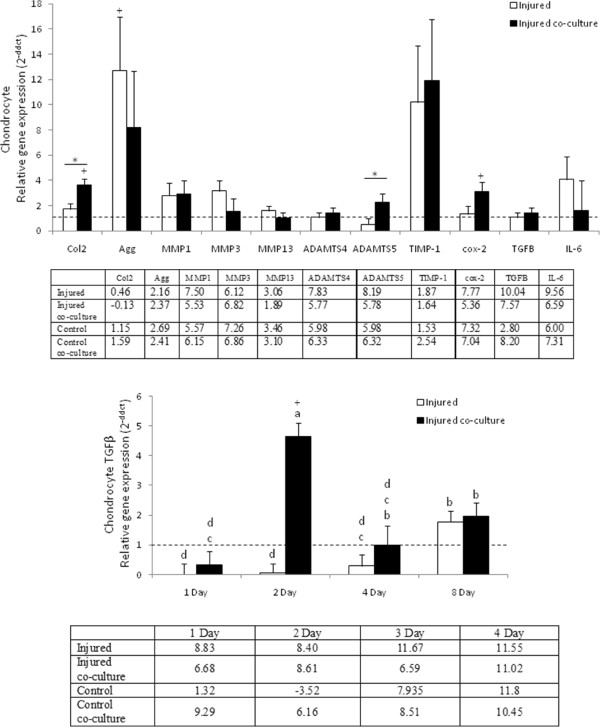
Chondrocyte gene expression. (A) Gene expression data for injured cartilage cultured alone or with synoviocytes. Data presented as mean relative expression across all time points for each culture condition (± SEM) * denotes statistically significant difference between pairs, + denotes statistically significant difference from baseline p-value < 0.05. (B) TGF-β expression was significantly affected by both treatment and duration in culture with a significant increase in expression in synoviocytes cultured with injured cartilage after 48 hours. Chondrocyte gene expression levels for injured cartilage are relative to expression of uninjured cartilage. Bars represent mean (± SEM), bars with the same letter for each pathology are not significantly different from each other, significance set at alpha (p-value) = 0.05, n = 6. Main effects or interactions were evaluated in the AOV table with a predictive F-value (Pr > F).